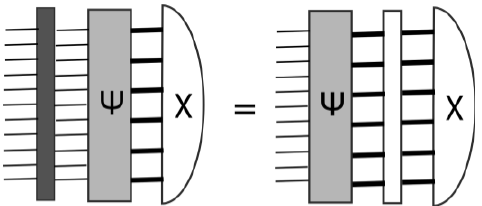
Figure 13 . An endomorphism of V represented by the dark (cid:12)lled box induces a map for the collective variable represented by the empty